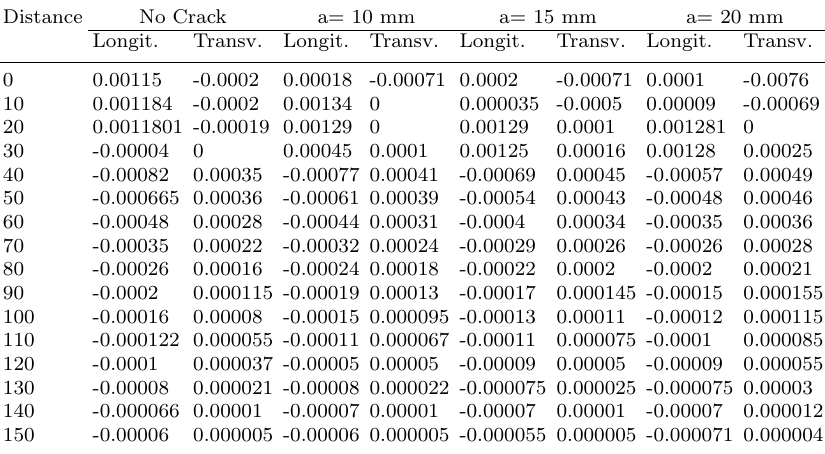
Table 5. Longitudinal and transverse strain for different crack lengths.